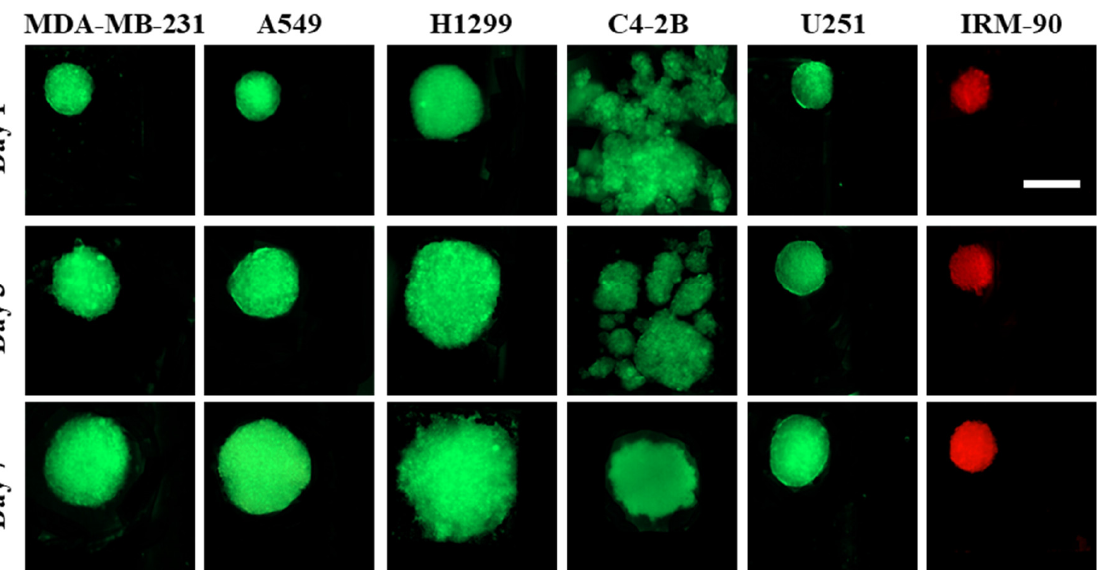
Figure 2. Spheroid formation on PDMS biochips pre-coated with 10% BSA. Fluorescent images of spheroids captured on days 1, 3, and 7 showed that each cell line had its own proliferation rate in the 3D model. All cell lines studied here were able to form spheroids during 7 days of culture. The red color is due to red-fluorescent protein (RFP) in IRM-90 cells and the green color is due to green- fluorescent protein (GFP) in MDA-MB-231 cells. For other cell lines, the green color is due to being fluorescently labeled with cell-labeling solution Vybrant Dio V22886. Scale bars: 200 μm.